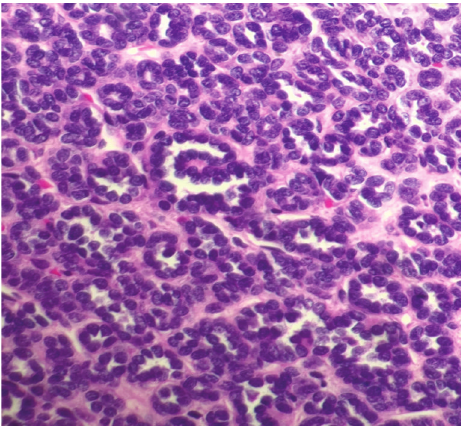
Figure 2: A micrograph at 400x magnification showing occasional glomeruloid structures in the center of the image.